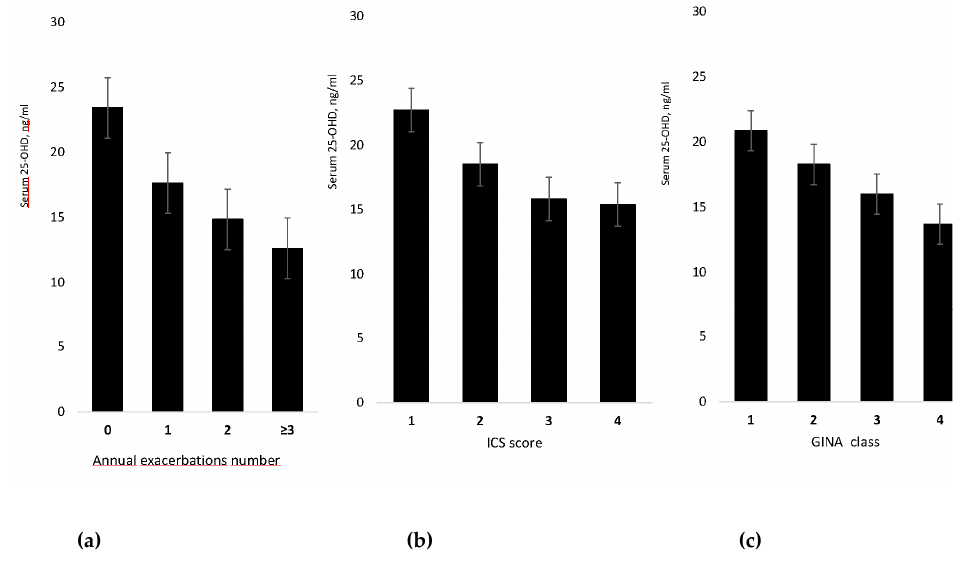
Figure 2. Mean value (with standard deviation) of serum level of 25-hydroxy vitamin D by annual exacerbation number ( a ), score of inhaled corticosteroids dose ( b ), and GINA class of asthma severity ( c